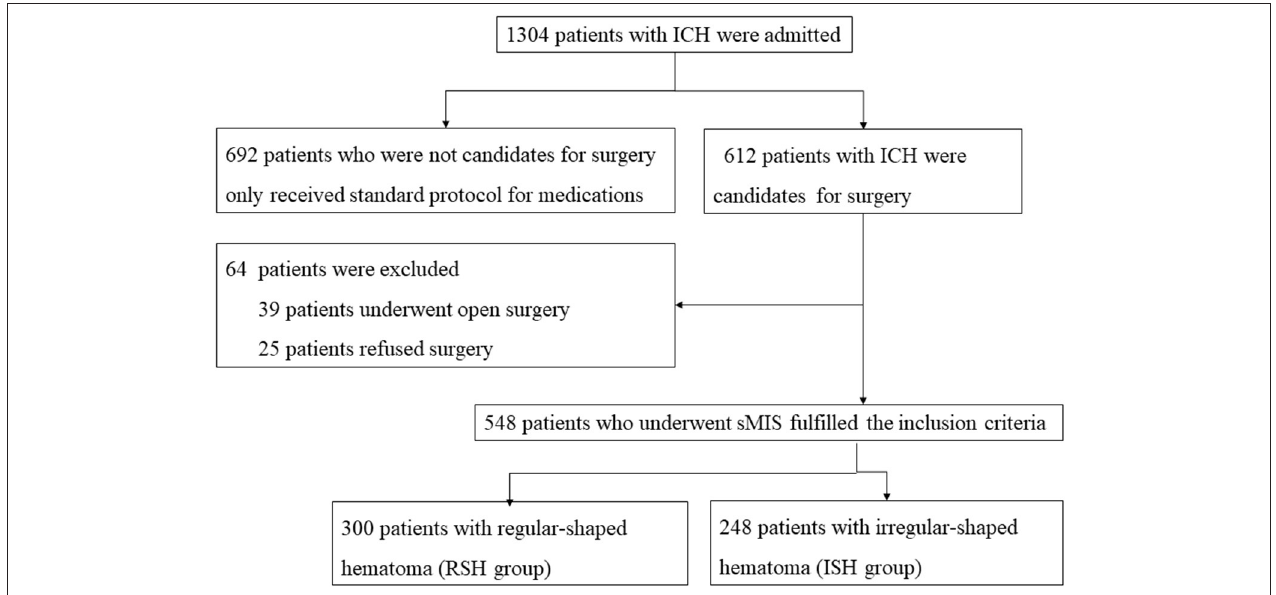
FIGURE 3 | Flowchart of patients‘ inclusion. During the study period, 1,034 patients with ICH were admitted to the Affiliated Hospital of Guizhou Medical University. Among them, 548 patients underwent stereotactic minimally invasive surgery for ICH evacuation. The irregular-shaped hematoma was found in 248 patients and regular-shaped hematoma in 300 patients.